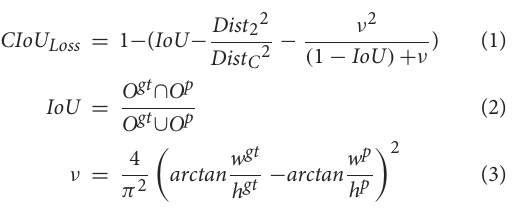
feature sizes (e.g., 80 × 80, 40 × 40, and 20 × 20) and